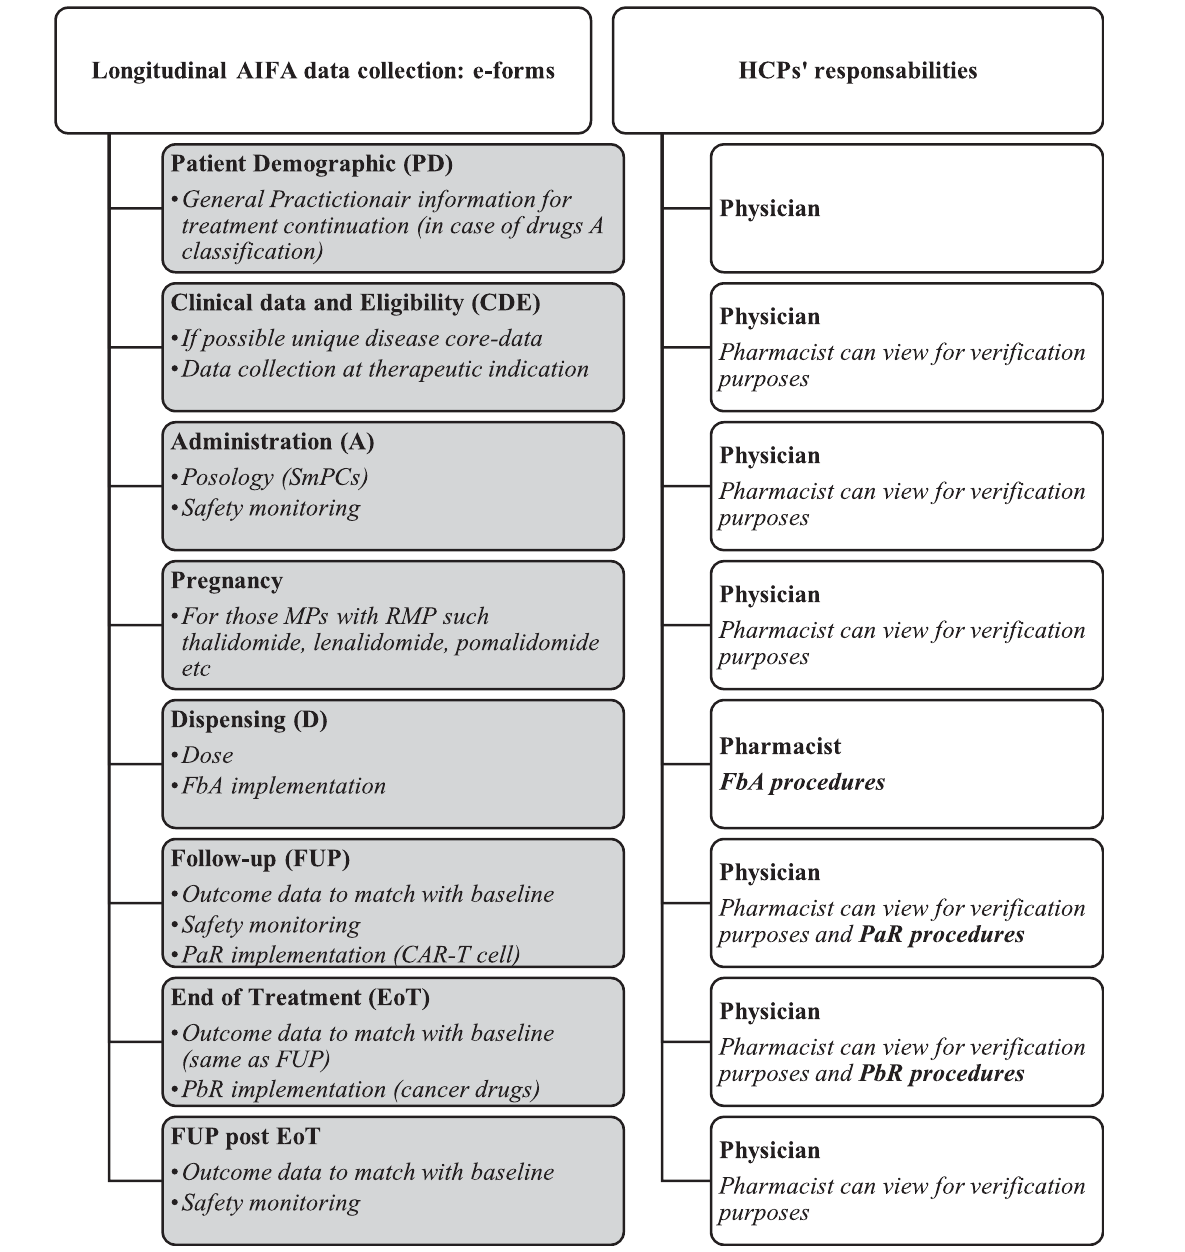
Frontiers in Pharmacology |